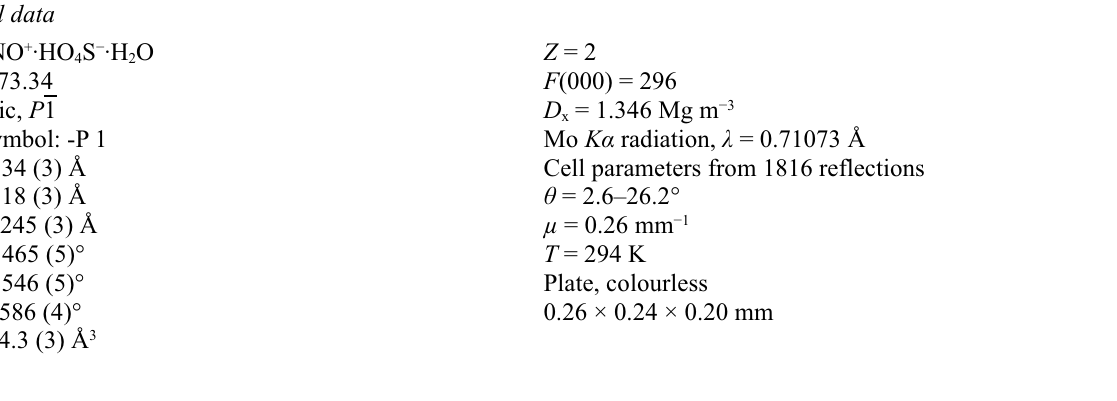
The content of asymmetric unit of (I) with the atomic numbering and 35% probability displacement ellipsoids. 4-Hydroxy-2,2,6,6-tetramethylpiperidinium hydrogensulfate monohydrat Crystal